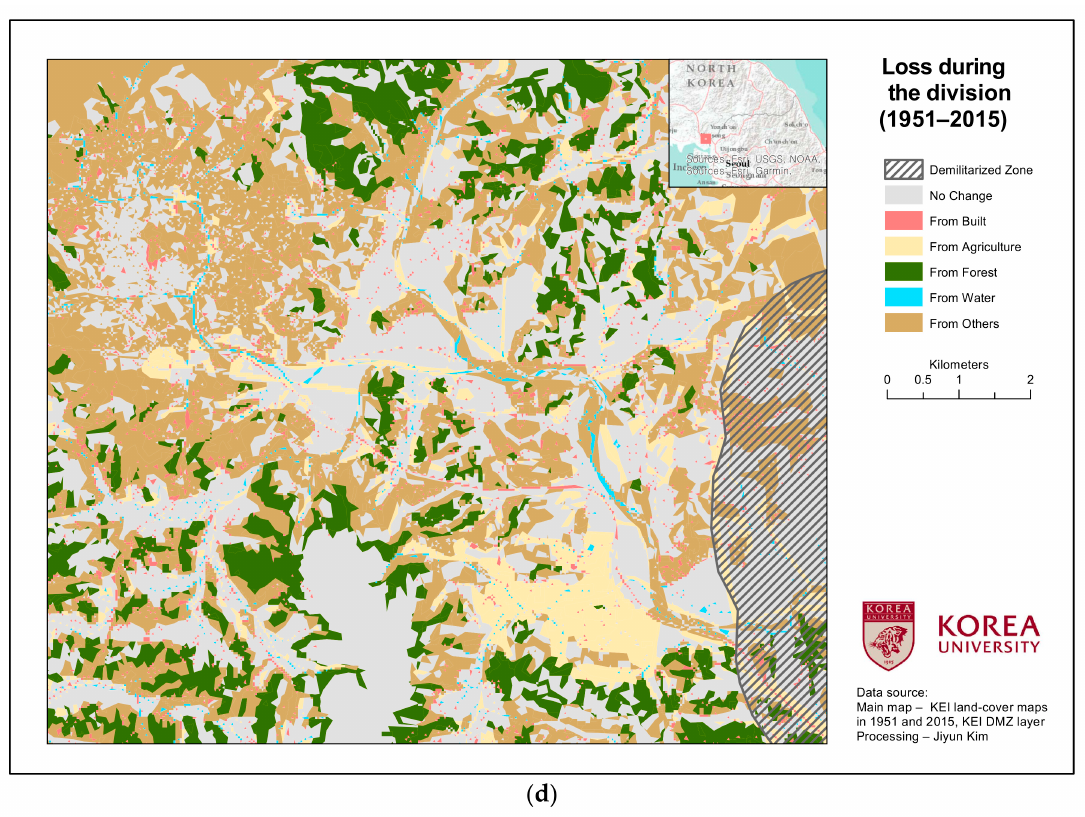
Figure 5. Change detection analyses: land-use and land-cover ( a , c ) gains and ( b , d ) losses under the colonial and division periods, respectively.